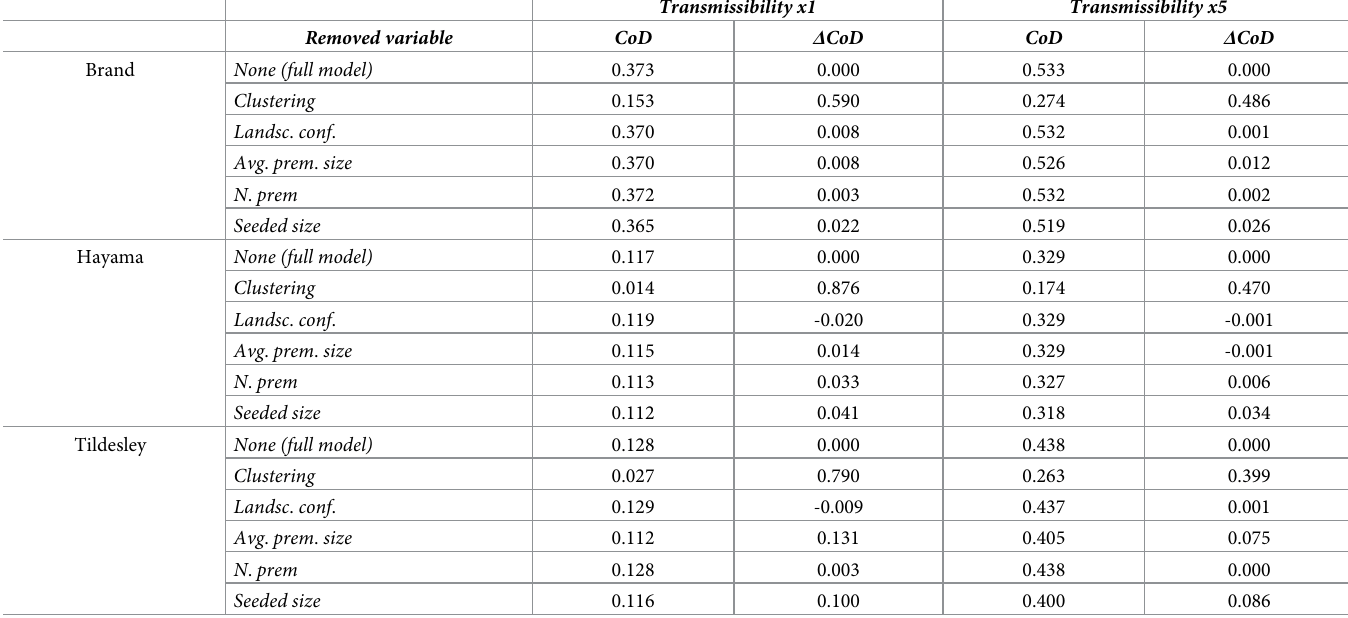
Table 2. Coefficient of discrimination ( CoD ) and relative change in CoD ( Δ CoD) as predictors are removed from logistic regression models predicting the probabil- ity of reaching 100 infected premises. The predictors are the county-level clustering at a spatial scale relevant for the kernel, K ^ r (random or FLAPS, Landsc . conf .), the logarithm of the average premises size in the seeded county, ln � n seeded county ( N . prem .), ln N and the logarithm of the premises size of the seeded premises, lnn w additional binary predictors indicating which out of ten different realizations of the landscape configuration are found in the supplementary material (S2 Table and S3